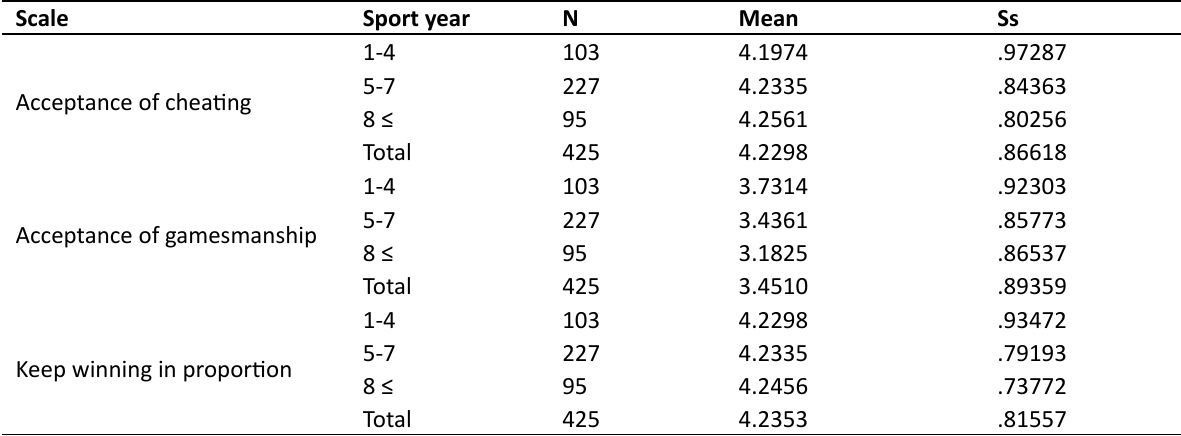
Table 5. Descriptive statistics and correlations between moral decision-making attitudes and prosocial and antisocial behaviors of young athletes (N = 425)